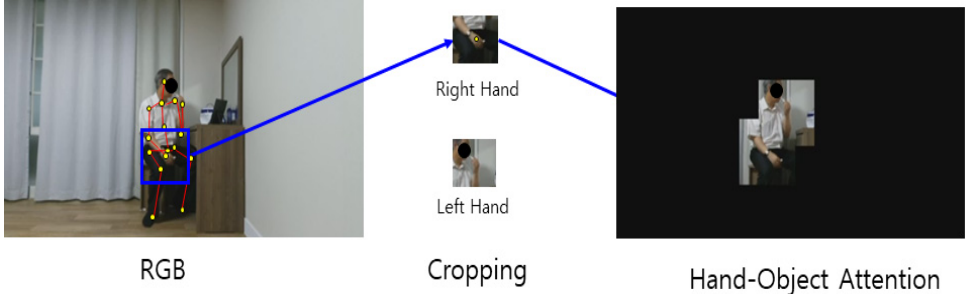
Figure 11. Hand–object ROI extraction process of RGB video using the skeleton.